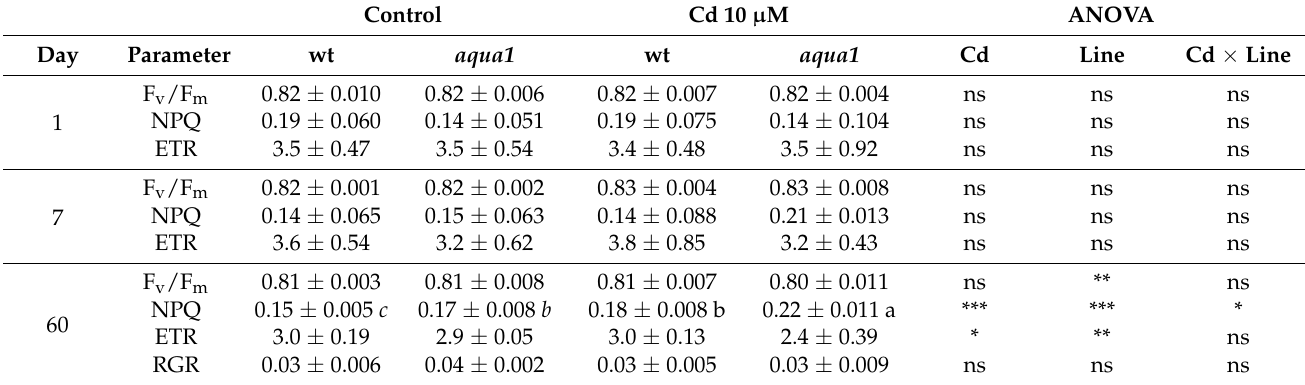
Table 2. Photosystem II efficiency parameters at 1, 7, and 60 d of Cd treatment and relative growth rate (RGR, g day − 1 ), F v /F m (maximum quantum efficiency of photosystem II), NPQ (non-photochemical quenching), ETR (electron transport rate) at 60 d calculated on dry biomass basis. The values represent the mean of three biological replicates ± SD. Data were analyzed with two-way ANOVA. The means were compared using a Tukey’s test ( p < 0.05). Different letters indicate significant differences ( p < 0.05). ns, not significant; * p < 0.05; ** p < 0.01; *** p <